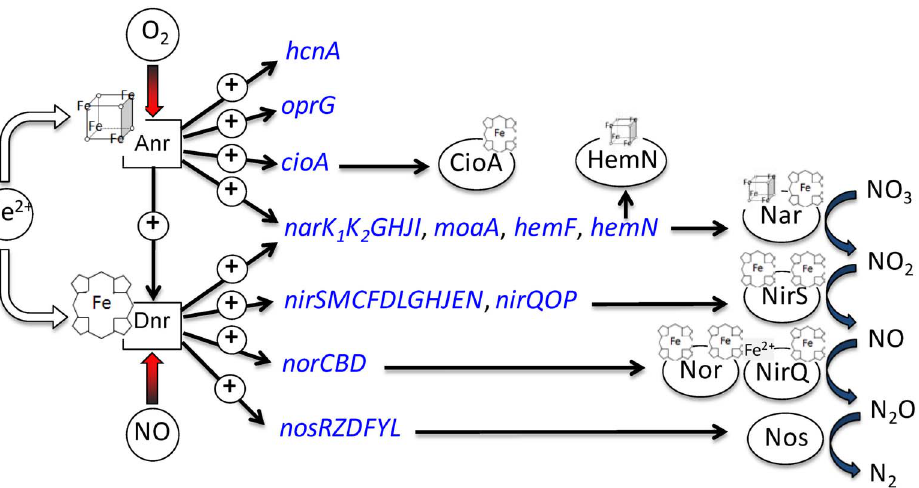
Figure 3. Influence of iron availability on the formation of the anaerobic respiration apparatus. Pairwise comparisons of transcriptome data between biofilms grown anaerobically on AUM and 10-fold diluted LB supplemented with 50 mM nitrate were performed. Expression of genes involved in anaerobic respiration found reduced in anaerobically grown biofilms on AUM are shown. Iron is essential for cofactor synthesis required for the anaerobic regulators Anr and Dnr as well as various enzymes of denitrification.